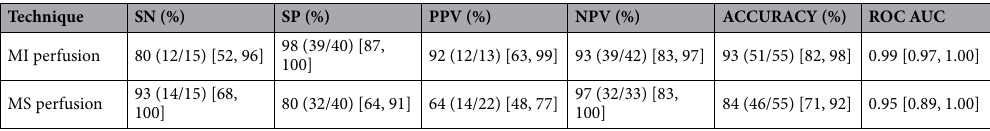
Table 2. Motion-immune (MI) and motion-susceptible (MS) CT perfusion-based detection of physiologically significant LAD stenosis. Parentheses indicate the fractional representation of measurements; Brackets indicate 95% confidence intervals. MI motion-immune CT perfusion, MS motion-susceptible CT perfusion, LAD left anterior descending coronary artery, SN sensitivity, SP specificity, PPV positive predictive value, NPV negative predictive value, ROC AUC area under the curve of the receiver operator characteristic.